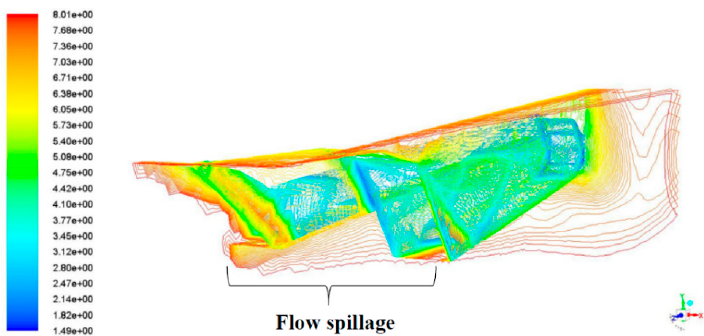
Figure 41. Mach contour of same orientation ramjet and scramjet inlets at Mach 8.